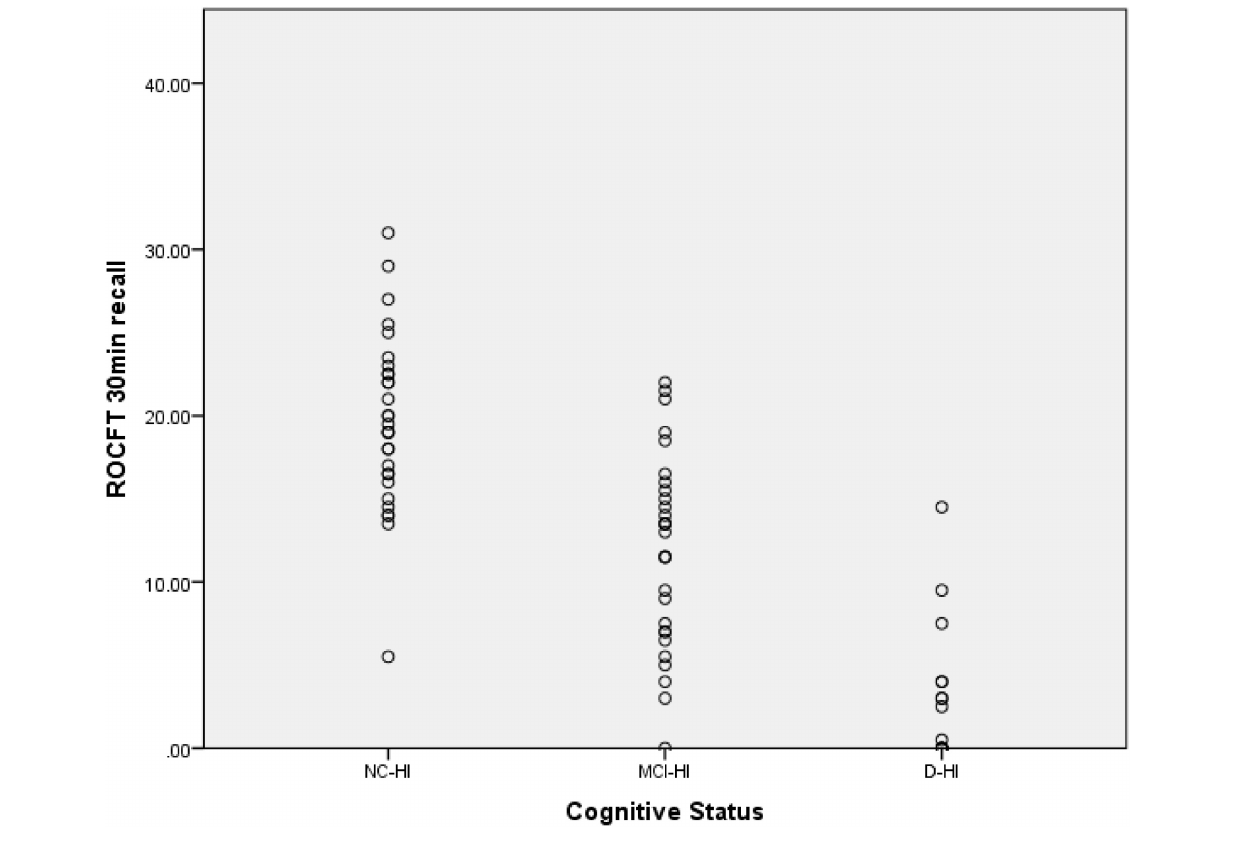
FIGURE 3 | Scatter plot for the ROCFT 30 min recall scores of the three